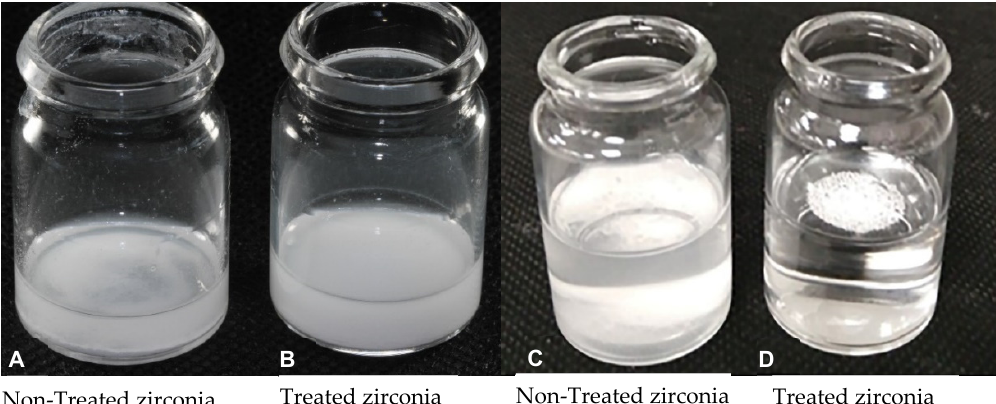
Figure 1. Photographs illustrating non-treated and silane-treated zirconia nanoparticles mixed in ( A , B ) monomer (MMA) and ( C , D ) water.